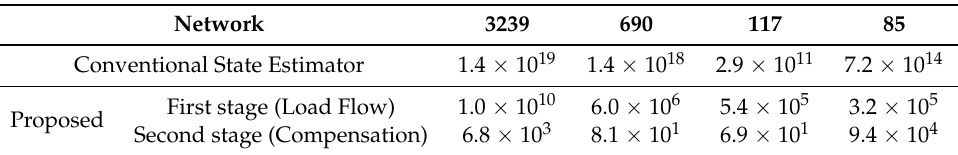
Table 2. Condition number for the tested